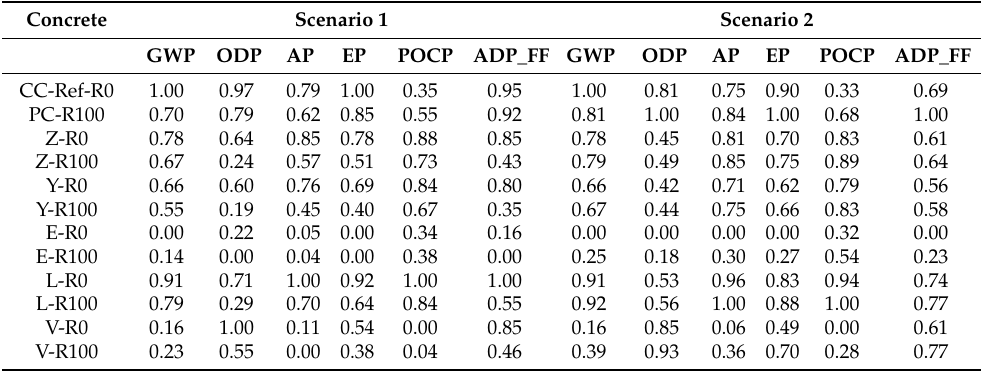
Table 14. Normalised values of the studied environmental impact